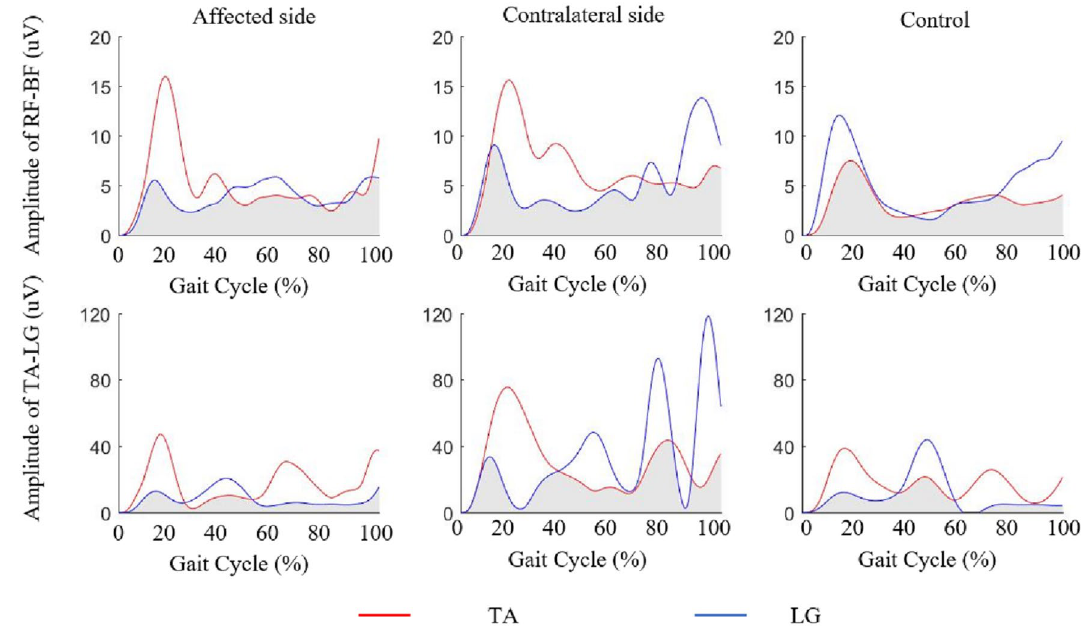
Figure 2. Schematic of lower limb muscle co-contraction. The representative electromyography (EMG) signals of the tibialis anterior (TA) and lateral gastrocnemius (LG) were extracted from one gait cycle in one lumbar disc herniation (LDH) patient and one healthy participant. The common area is the overlapping region under the curves of the EMG signals and represents the amount of muscle co-contraction. (MATLAB 2016a https :// www.mathw